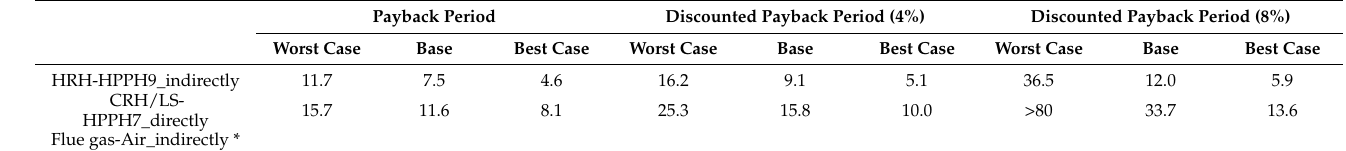
Table 13. Payback period in years for total